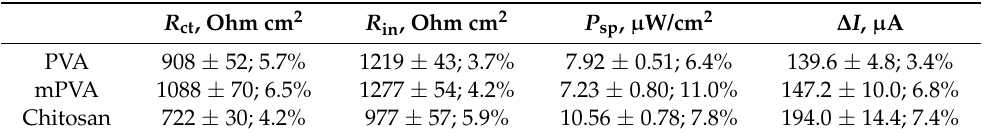
Table 2. Values of the bioelectrochemical characteristics of electrodes modified by various polymers and multiwalled carbon nanotubes (MWCNT). R ct , Ohm cm 2 R in , Ohm cm 2 P sp , μW/cm 2 R ct , Ohm cm 2